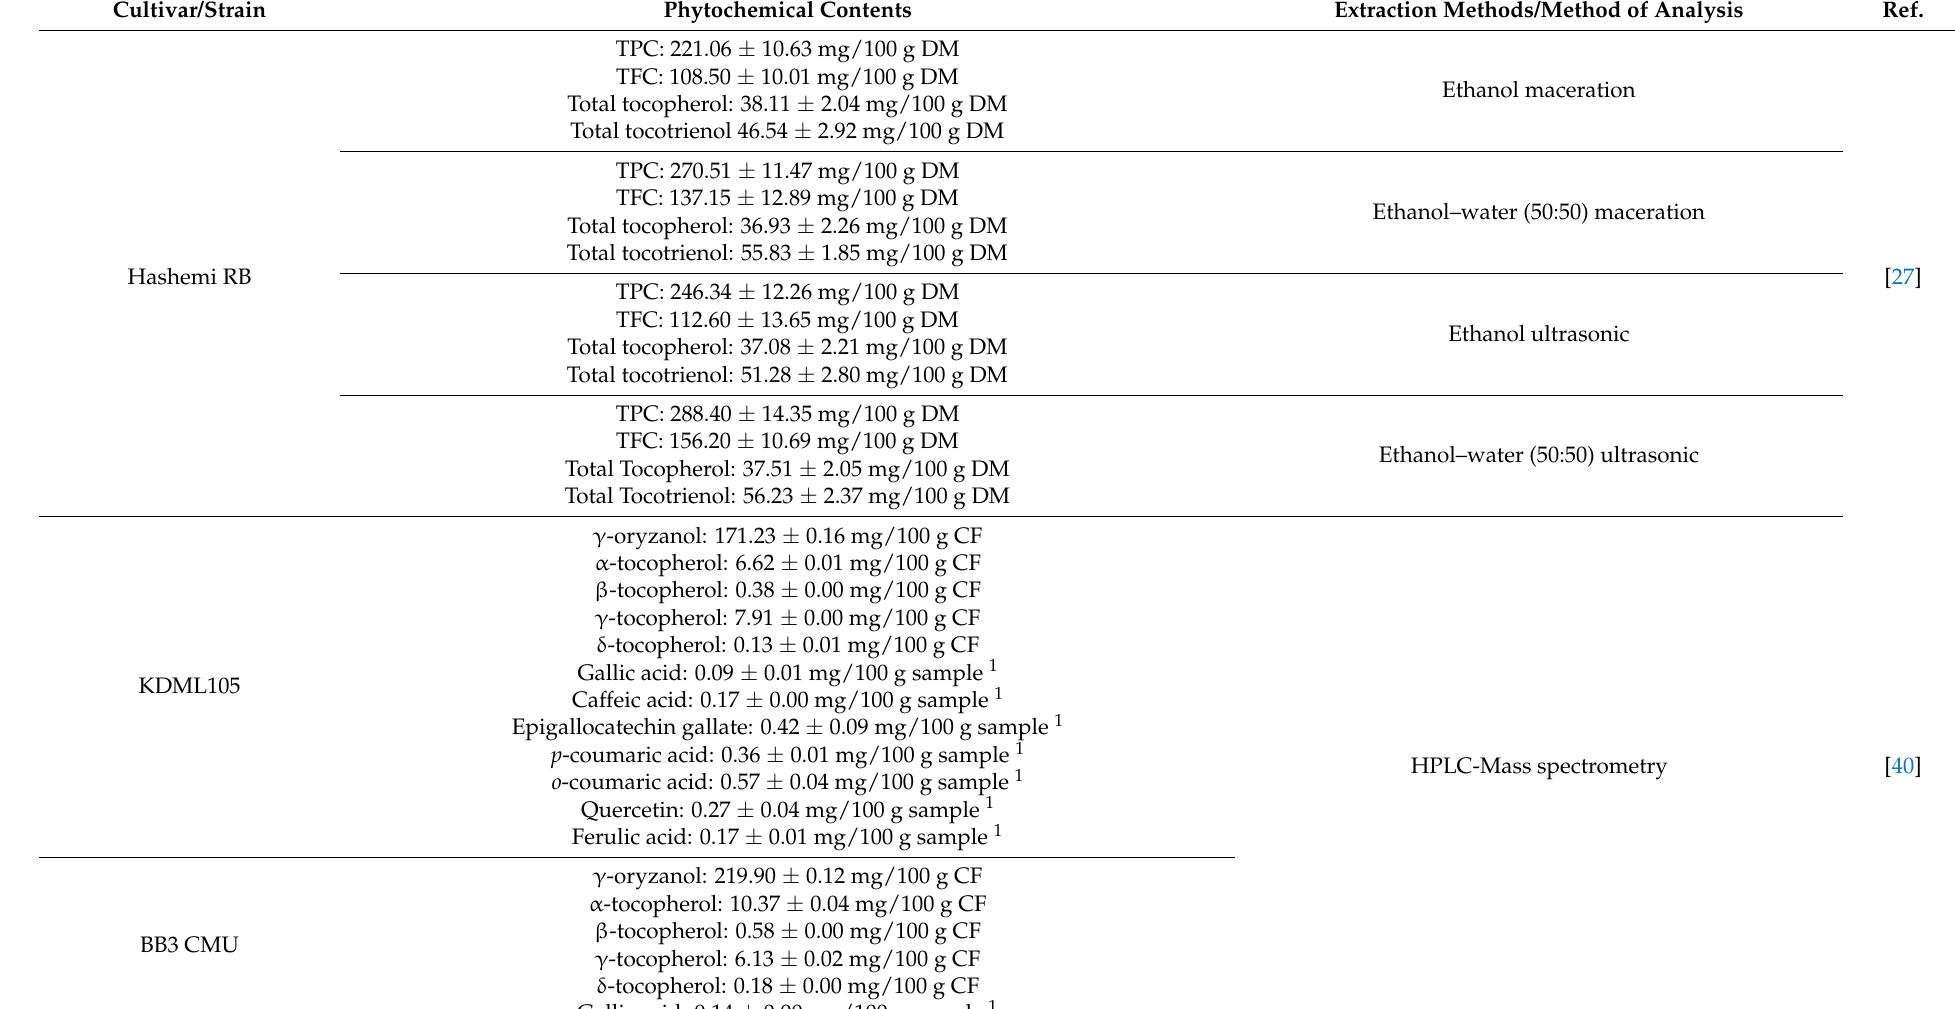
Table 1. Details of the phytochemical composition of rice bran (RB) of different rice